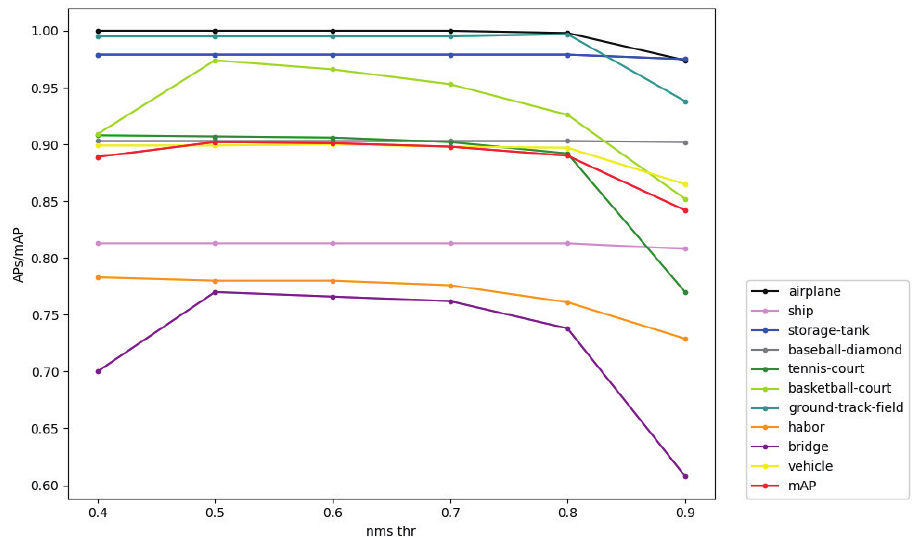
Figure 11. The impact of nms threshold on mAP value of RADet and AP values of different